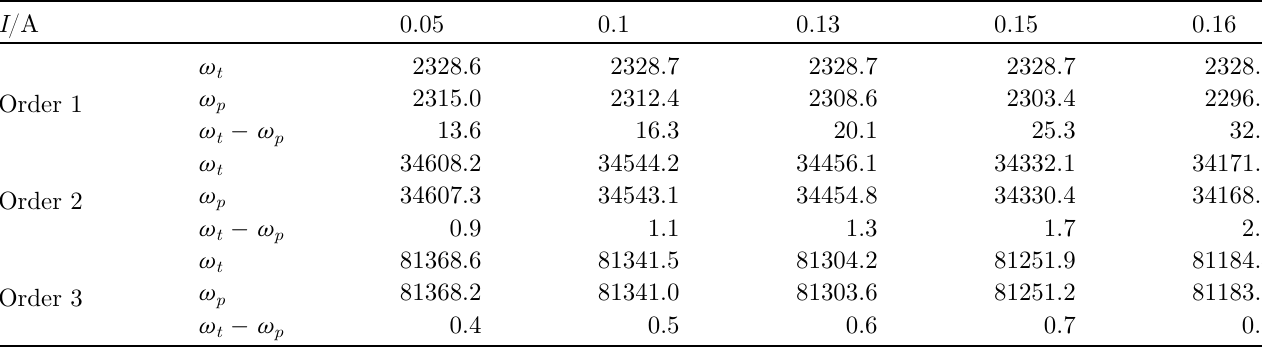
Table 12. Changes of natural frequency with I with and without damping